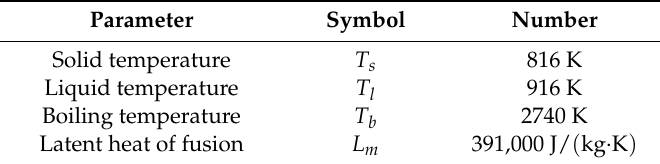
Table 4. Thermo-physical properties of AA2219